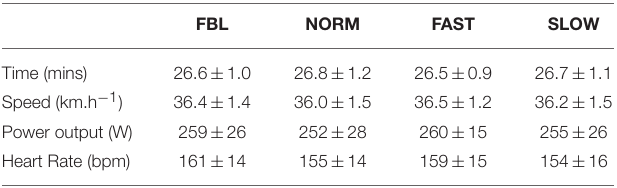
TABLE 1 | Mean ± SD values for whole trial variables during each trial condition.